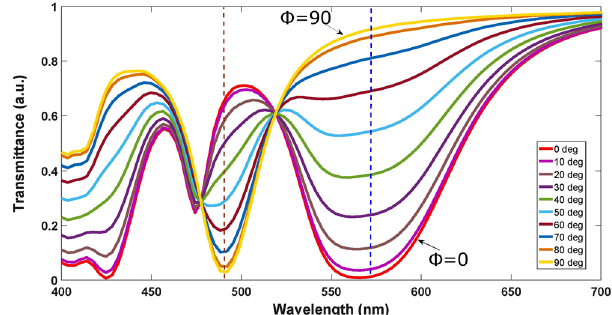
Figure 3. Shift in transmittance spectra when Φ is varied from 0° to 90°. Dashed lines indicate two resonance cases with strong transmission contrast between two orthogonal polarization states ( Φ = 0° and Φ = 90°).